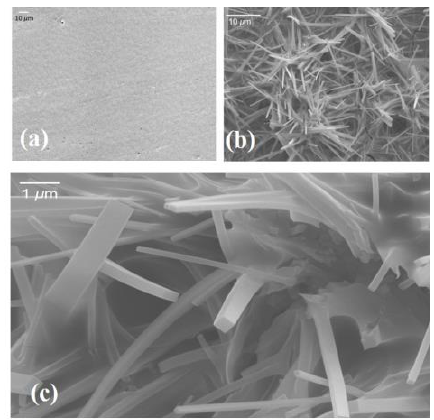
Figure 2. ( a ) SEM image of the surface morphologies of MZN thin film. ( b ) Plan-view SEM data of MZN NR nucleation layer that was formed in situ on an ITO surface from the decomposition of the MZN precursor at 60 °C. MZN NRs were grown for 23 h. ( c ) High-resolution SEM image of MZN NRs.